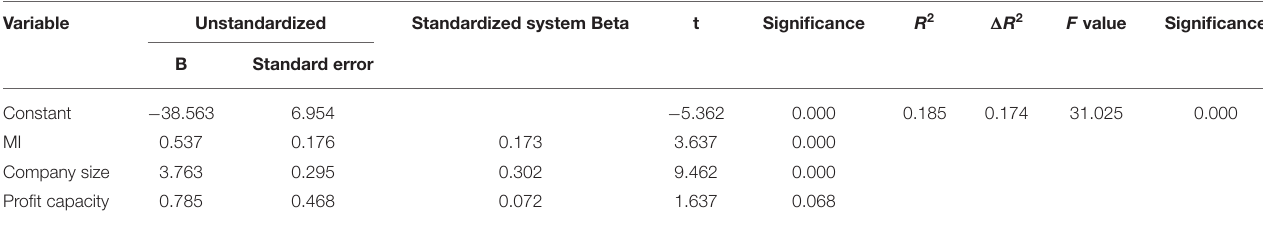
TABLE 3 | Marketization process and corporate social responsibility regression analysis